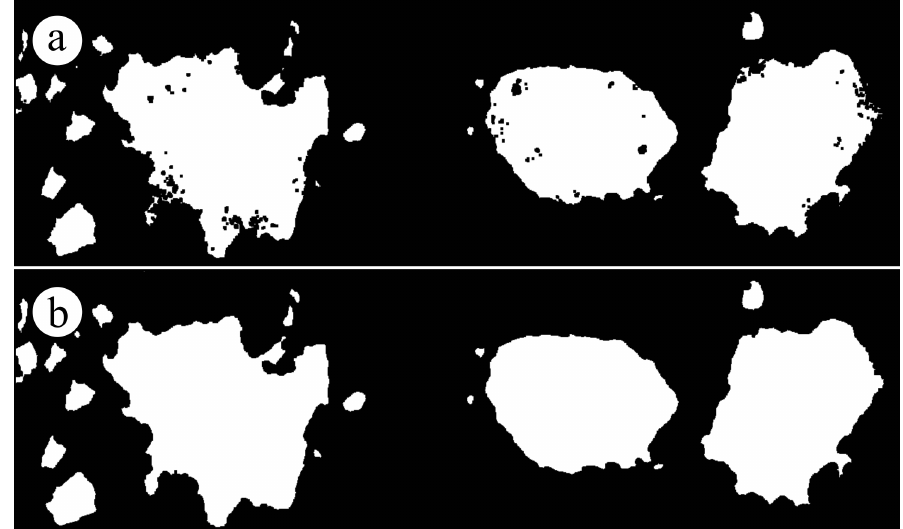
Figure 9. ( a ) Quality of the dense cloud after the detection of ground points on a detail. Some outliers are still present; ( b ) Quality of the dense cloud after the application of the statistical outlier removal (SOR) filter on the same detail. Outliers have been